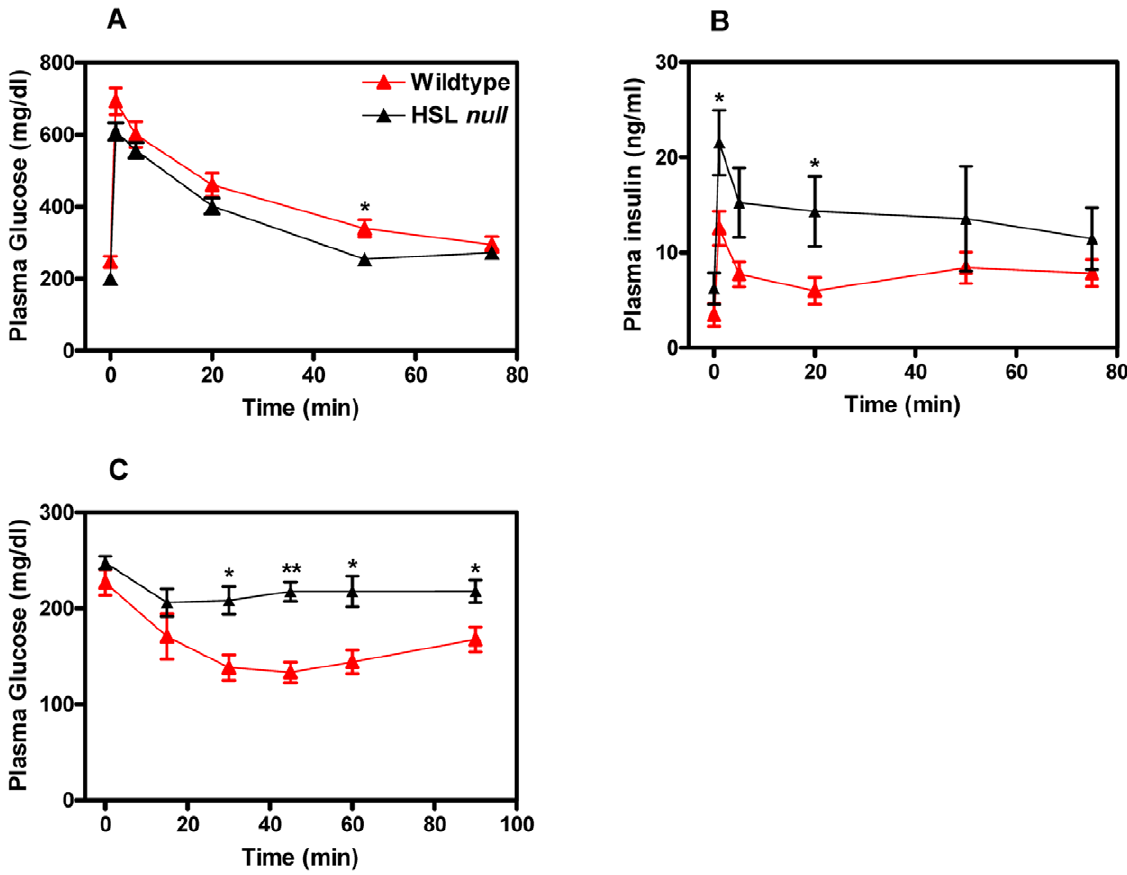
Figure 8. HSL null mice on a HFD show signs of impaired insulin sensitivity. Plasma levels of glucose (A) and insulin (B) after an intravenous glucose tolerance test (IGTT) performed on fasted (6 h) female mice after 24 weeks of HFD (n=5–6). (C) Plasma insulin levels after an insulin tolerance test (ITT) performed on non-fasted female mice after 18 weeks of HFD (n=6). Values given are mean 6 SEM, *p , 0.05, **p , 0.01, analyzed with Mann- Whitney U tests.